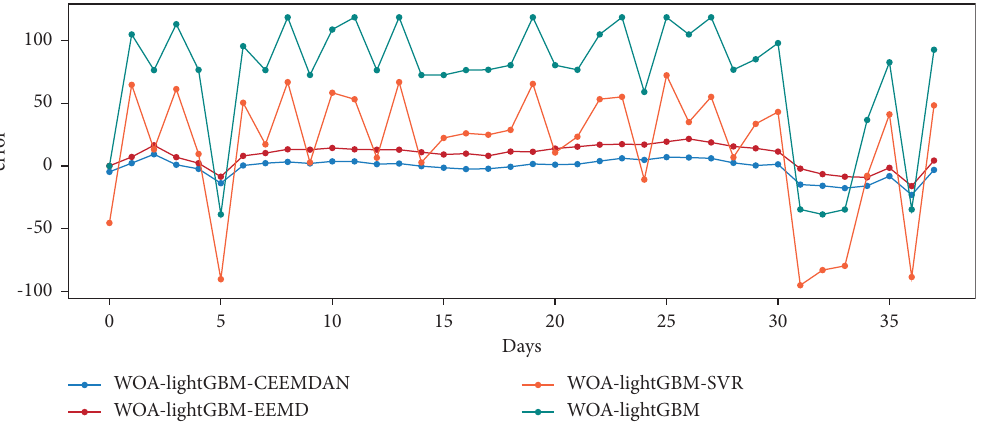
Figure 6: Model prediction error analysis.